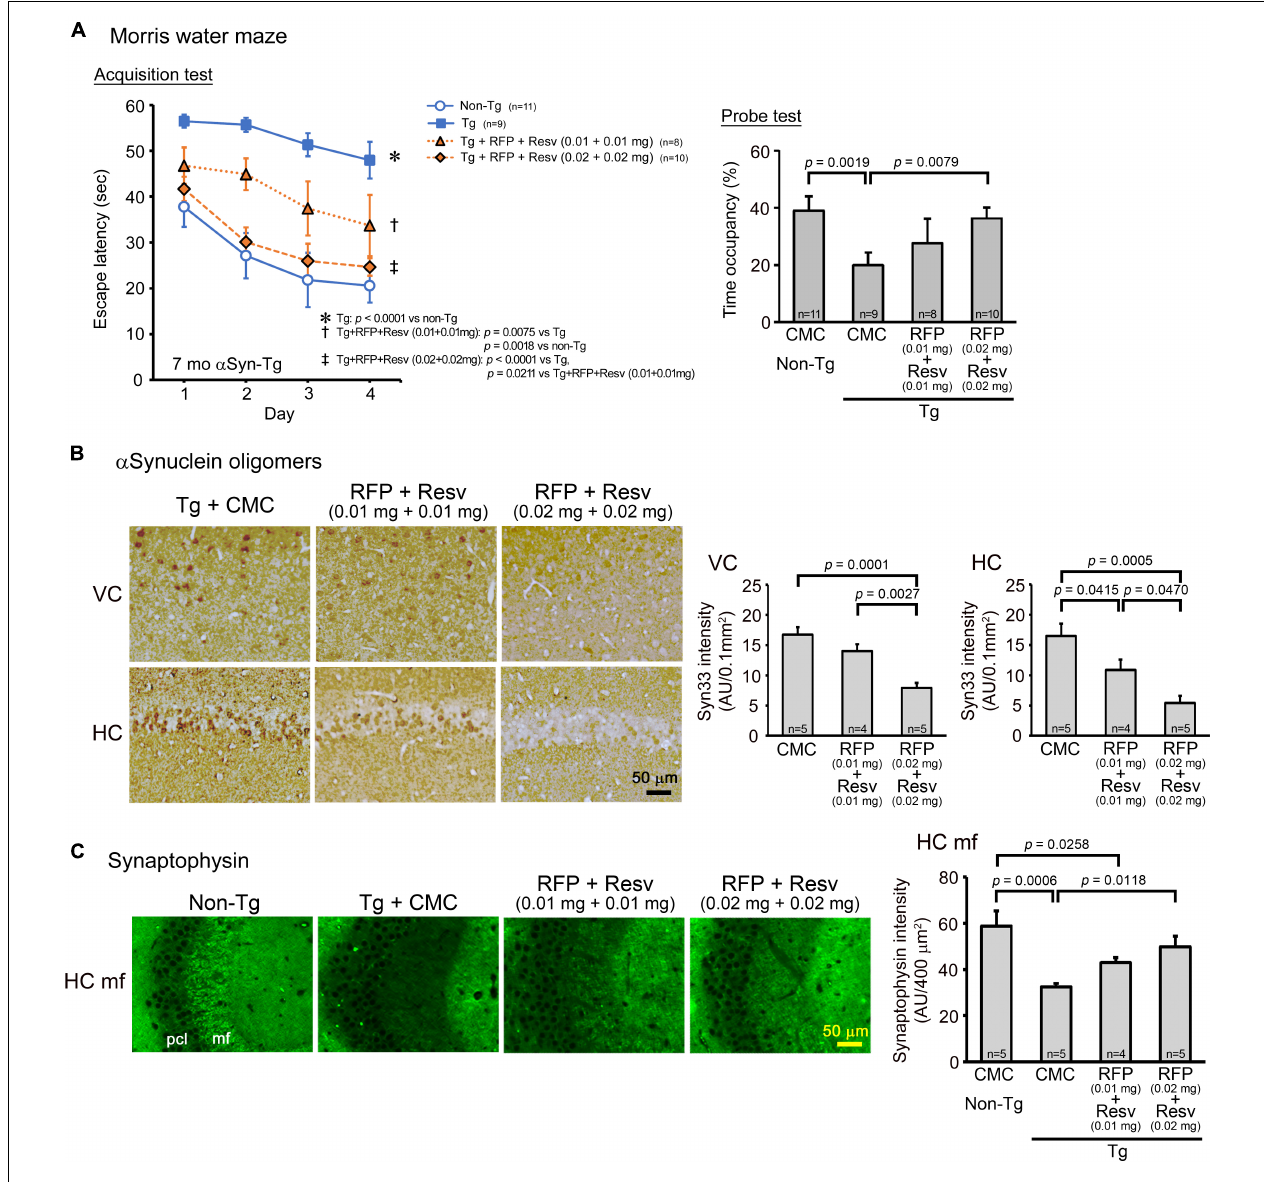
FIGURE 5 | Effects of intranasal rifampicin and resveratrol combination on memory and α -synuclein oligomer-related pathologies in α Syn-Tg mice. Drug solution containing 0.02 or 0.04 mg combinatorial medicine (0.01 or 0.02 mg each drug) or carboxymethylcellulose (CMC) was intranasally administered every day into 6-month-old mice for 1 month. (A) In the Morris water maze, the combinatorial medicine showed a significant improvement of mouse memory, but to reach a level similar level of non-Tg littermates required the higher dose. (B,C) After the water maze task, brain sections were stained with antibodies for α -synuclein oligomers (Syn33) and synaptophysin. (B) The levels of α -synuclein oligomers in the visual cortex (VC) and hippocampus (HC) were significantly attenuated by the combinatorial medicine at the higher dose (0.04 mg/day). (C) The level of synaptophysin in the hippocampal mossy fibers (HC mf) was significantly recovered by the combinatorial medicine (0.04 mg/day) to a level similar of non-Tg littermates. pcl, pyramidal cell layer. AU, arbitrary unit. Values in each figure represent the mean ±